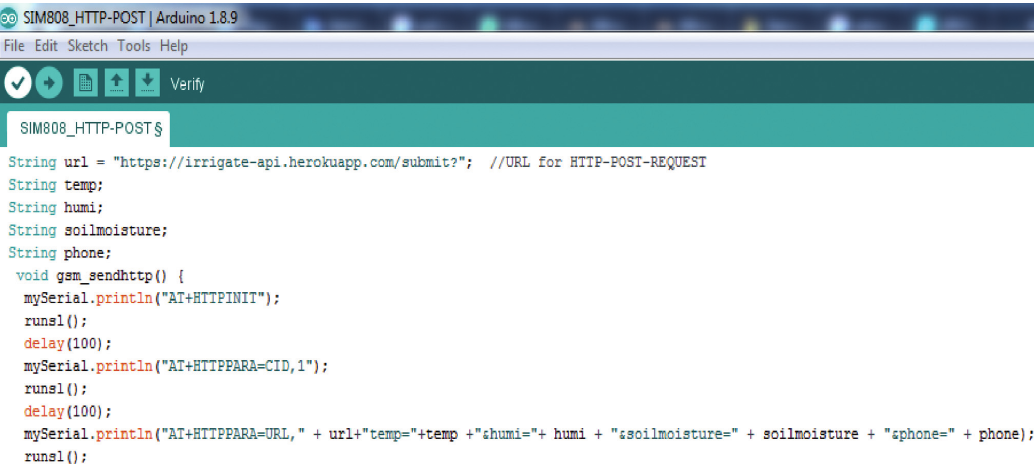
Figure 9: HTTP request sending to store sensor data.